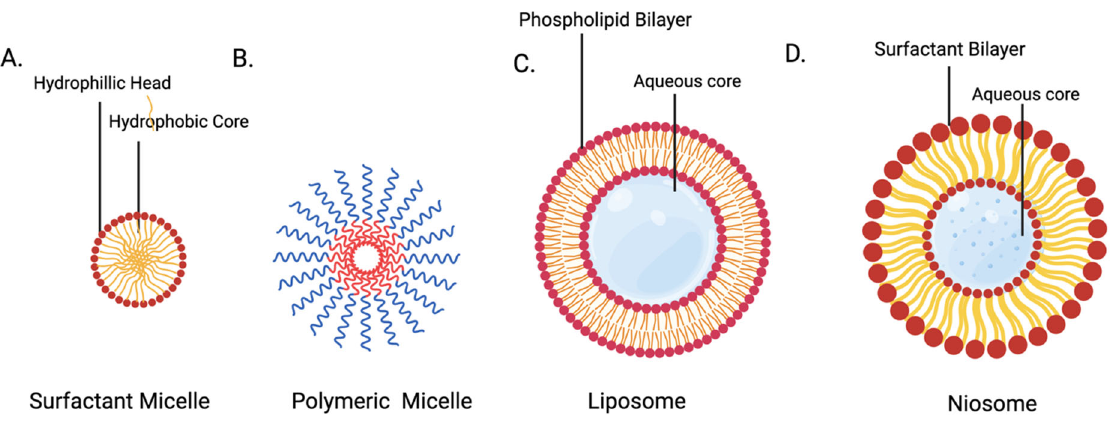
Figure 4. The structures of nanomicelles., liposomes, and niosomes ( A ) Surfactant micelles are grouped molecules of amphipathic lipids that create a hydrophobic core. Their sizes can vary but generally range from 10–100 nm. ( B ) Polymeric micelles contained amphiphilic copolymer that, when exposed to water, automatically forms a core/shell structure that can be loaded with insoluble drugs. They are typically between 10–100 nm in size. ( C ) Liposomes consist of an amphiphilic phospholipid bilayer that encloses hydrophilic substances and are typically between 25 and 2500 nm in size. ( D ) Niosomes are composed of non-ionic surfactant that form a vesicle to transport aqueous material. They are typically between 25 and 100 nm in size.